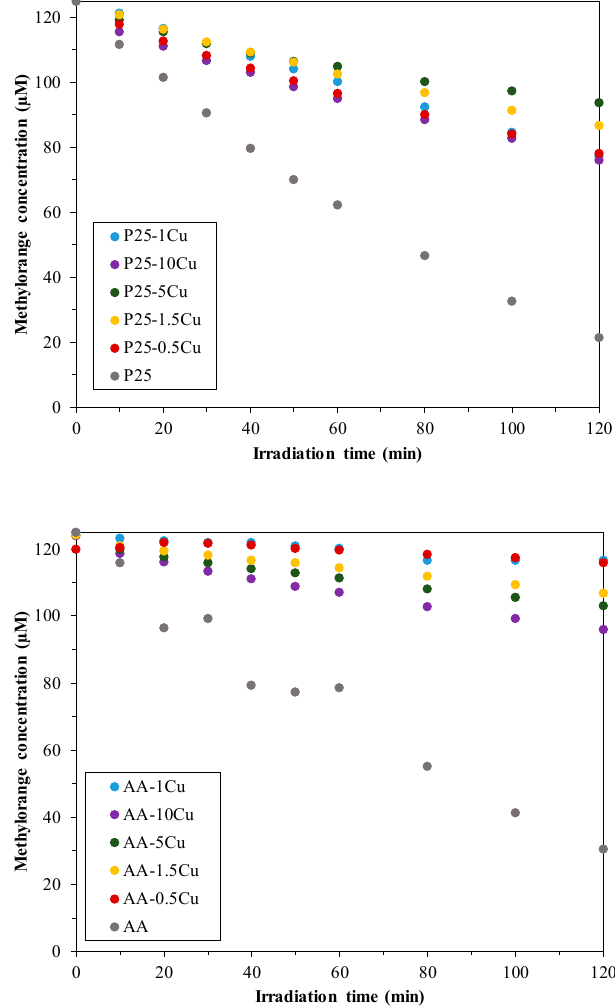
Figure 5. Degradation of methyl orange under UV illumination—the composites did not show better activity than the corresponding bare titania. P25-based composites proved to be more efficient than the AA-based ones.